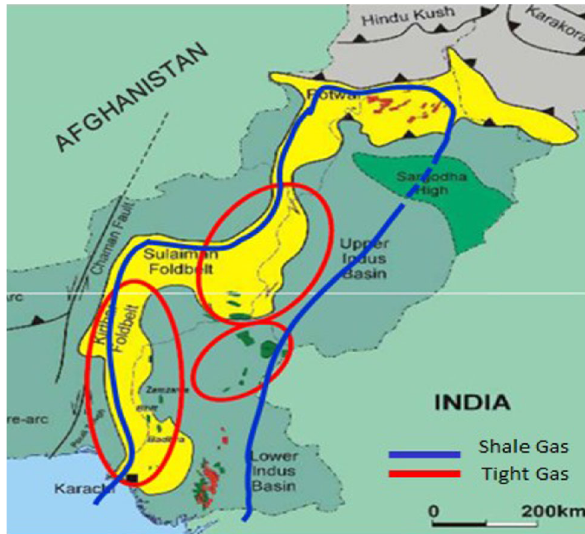
Fig. 8 Pakistan’s unconventional resources position, i.e. tight gas and shale gas and total known tight gas sources Pakistan Sources : Eni, OGDCL and OMV Pakistan and Khan